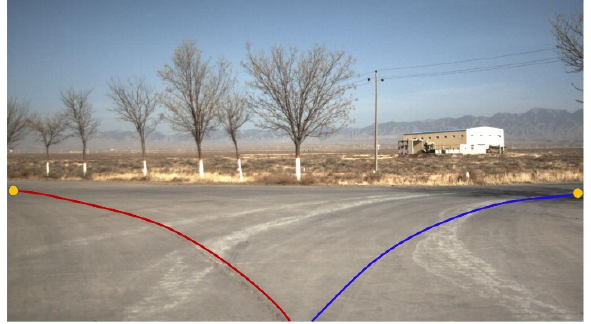
Figure 21. Superimposed candidate trajectories on the video image.